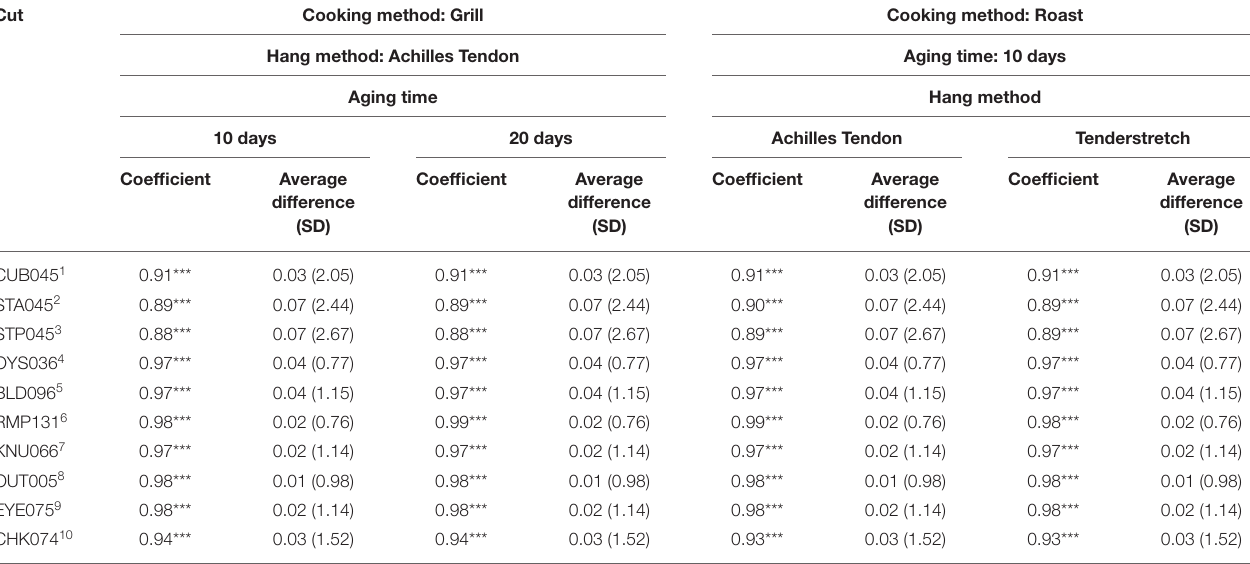
TABLE 4 | Pearson correlations and average differences between the MQ4 scores predicted by the marbling score assessed at the fifth rib and the tenth rib. Cut Cooking method: Grill Cooking method: